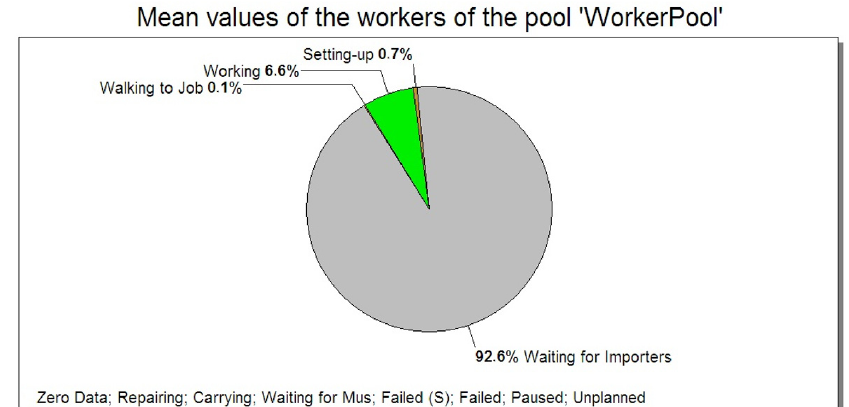
Figure 11. Percentage distribution of controller activities after the change [35].